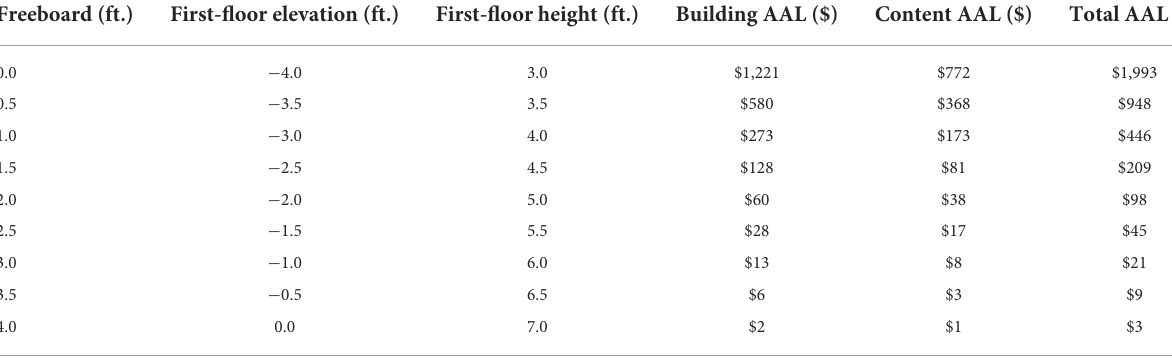
TABLE 2 AAL results for each freeboard scenario using USACE (2000) for Metairie, Louisiana, case study. Freeboard (ft.)